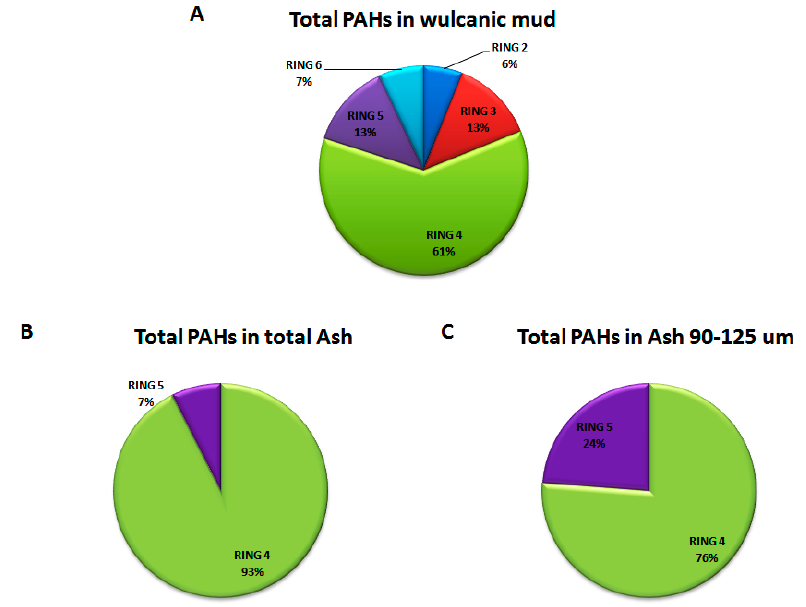
Figure 5. Percentage content of individual PAHs against total PAHs mass detected in the samples: A ‐ mud [33]; B ‐ total ash [37]; C ‐ fraction of ash [37].